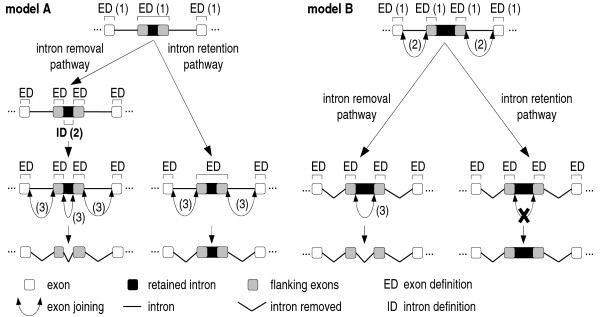
Bipartite model of intron retention. (A) "Two-step splice site recognition" (a mixed model of exon and intron recognition) for short introns in short "exon + intron + exon" units (< 400 nt, close to the size limit for exon recognition). In step 1, all the exons are defined, including the "exon + intron + exon" unit in black and gray. Step 2 is alternative, if intron definition occurs in the "exon + intron + exon" unit, the intron will be removed. Skipping of this step will lead to intron retention. (B) Model for long introns, typically with high scoring splice sites in long "exon + intron + exon" units. Step 1: exons are defined, including those flanking the intron to be retained (gray exons). In step 2, flanking introns are removed, joining the retained intron flanking exons to the outer exons. Step 3 is alternative, if the flanking exons are joined, the intron is removed; otherwise, abrogation of this step by hypothetical failure in E to A or A to B complex transition would lead to intron retention.